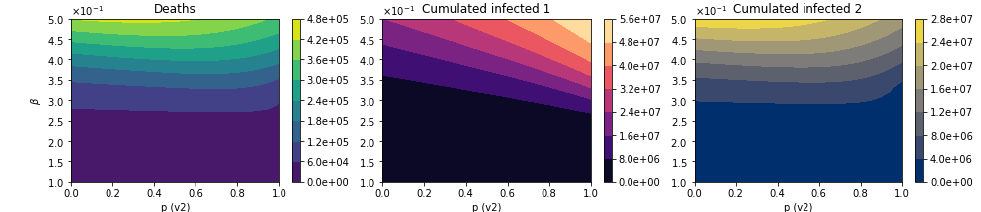
Figure 13. Total number of deaths and the cumulative number of infected people for each age group. This scenario considers a ratio r = 10. The factor that is varied is the SARS-CoV-2 transmission